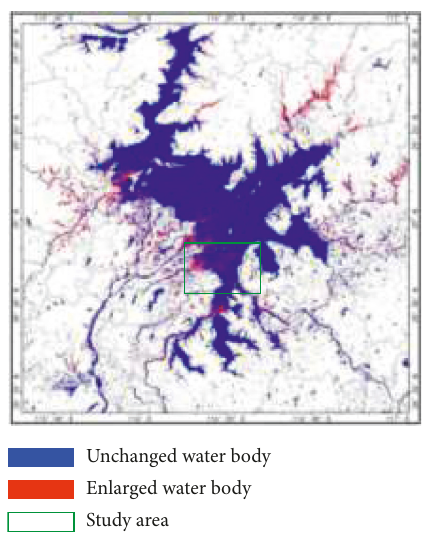
Figure 2: Flood change monitoring in Poyang Lake area.